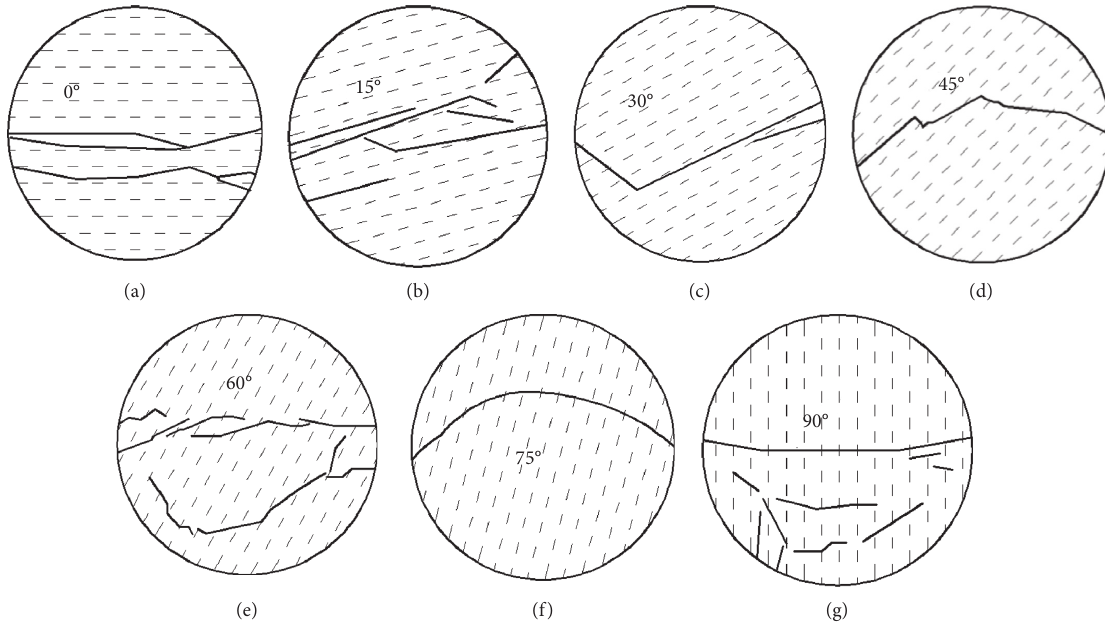
Figure 15: Failure of the rock